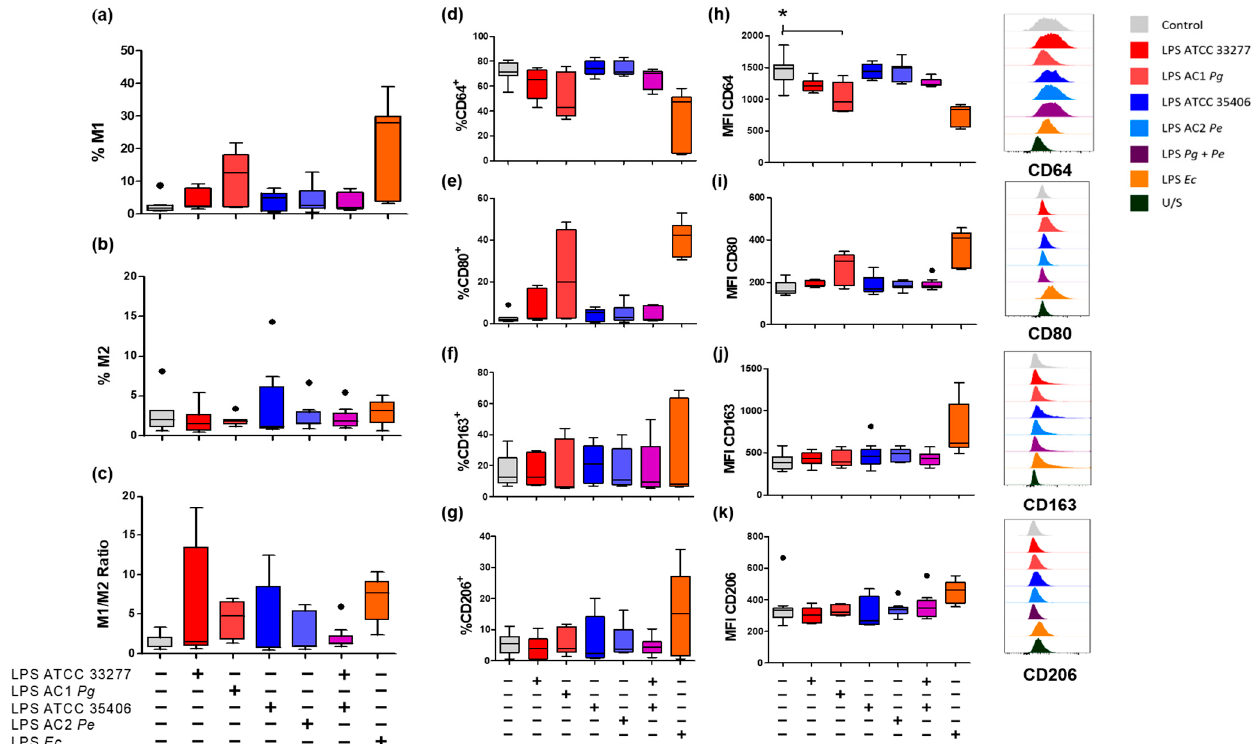
Figure 2. Percentages of M1 and M2 macrophage populations in LPS-stimulated macrophages in vitro. Box and whisker plots represent the median and interquartile range of ( a ) Percentage of CD64 + CD80 + for M1 macrophages. ( b ) CD163 + CD206 + for M2 macrophages. ( c ) M1/M2 ratio. ( d ) CD64 + , ( e ) CD80 + ( f ) CD163 + and ( g ) CD206 + cell percentage, respectively. ( h ) Mean fluorescence intensity (MFI) of CD64, ( i ) CD80, ( j ) CD163 and ( k ) CD206 respectively of THP-1 macrophages in vitro stimulated for 24 h with LPS. U/S Unstained. Independent experiments were performed in triplicate. Data were analyzed by the Kruskal-Wallis test. ( ● ) Represents outlier data. ( n = 3) * p < 0.05.